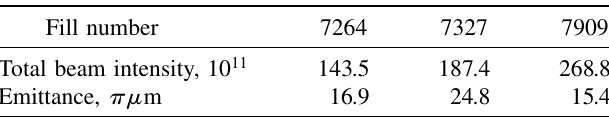
TABLE III. Comparison of the fills 7264, 7327 in run 2005, and the fill 7909 in run 2006. The emittance is at the early store (1.5 hours after the ramp